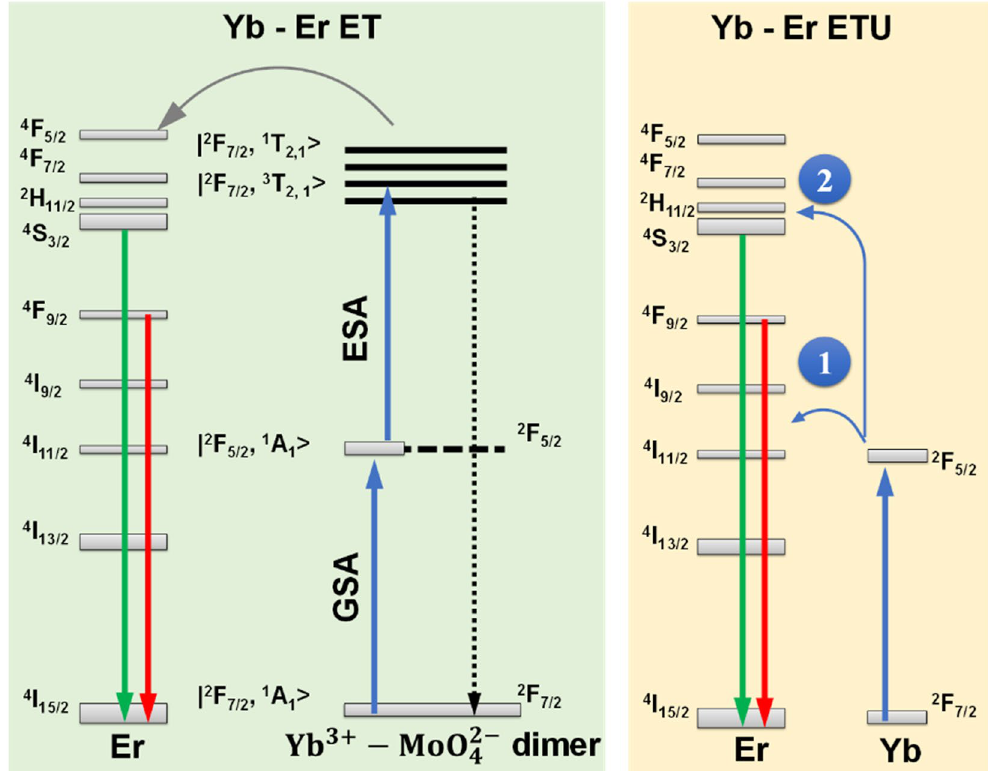
Figure 6. Upconversion mechanisms in the Mo-Yb dimer model versus standard sequential Yb-Er energy transfer (ETU). Numbered circles refer to Yb—Er ETU steps.